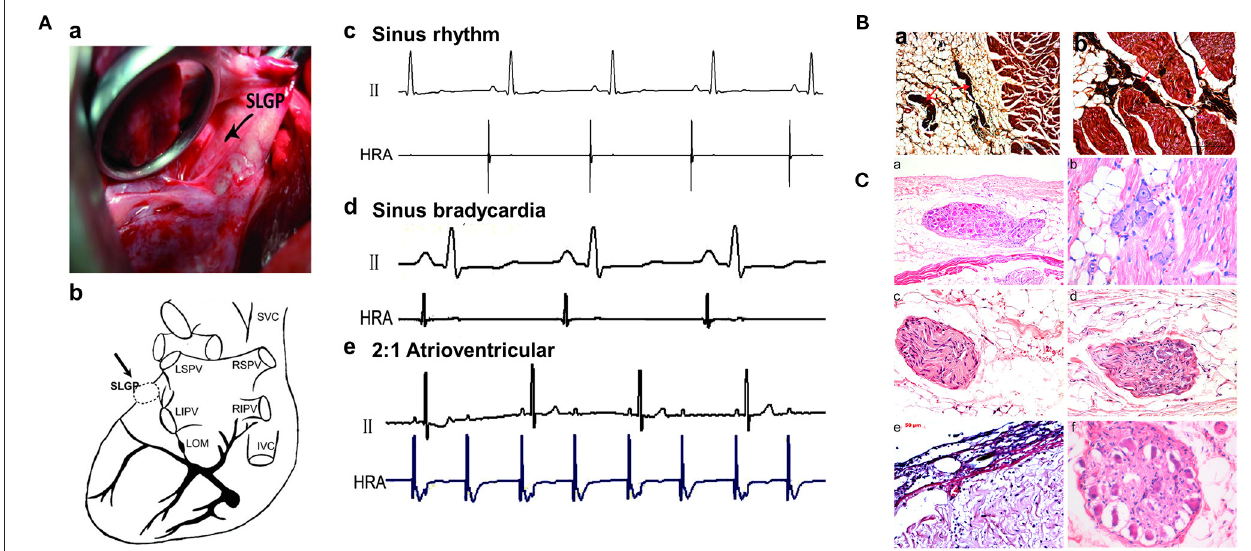
FIGURE 2 | Changes in SLGP before and after ablation. (A) Location of the SLGP. The place marked with an arrow is the position of the SLGP (a,b); before and after SLGP stimulation, different types of arrhythmias were observed (c–e). (B) Silver staining of the SLGP. (C) Representative images of HE staining for SLGP: (a) dozens of neurons in SLGP were observed in subepicardial fat tissue; (b) several neurons were observed between cardiac muscle; (c) The nerve fibers and neurons in a nerve bundle; (d) the nerve fiber bundle; (e) disorder of subepicardial collagen tissue structure after SLGP ablation; (f) ganglion cells developed vacuolar degeneration after SLGP ablation. SVC, superior vena cava; IVC, inferior vena cava; RSPV, right superior pulmonary vein; RIPV, right inferior pulmonary vein; LSPV, left superior pulmonary vein; LIPV, left inferior pulmonary vein; SLGP, superior left ganglionated plexus; LOM, ligament of Marshall; HRA, high right atrium; HE, hematoxylin and eosin; other abbreviations as in Figure 1